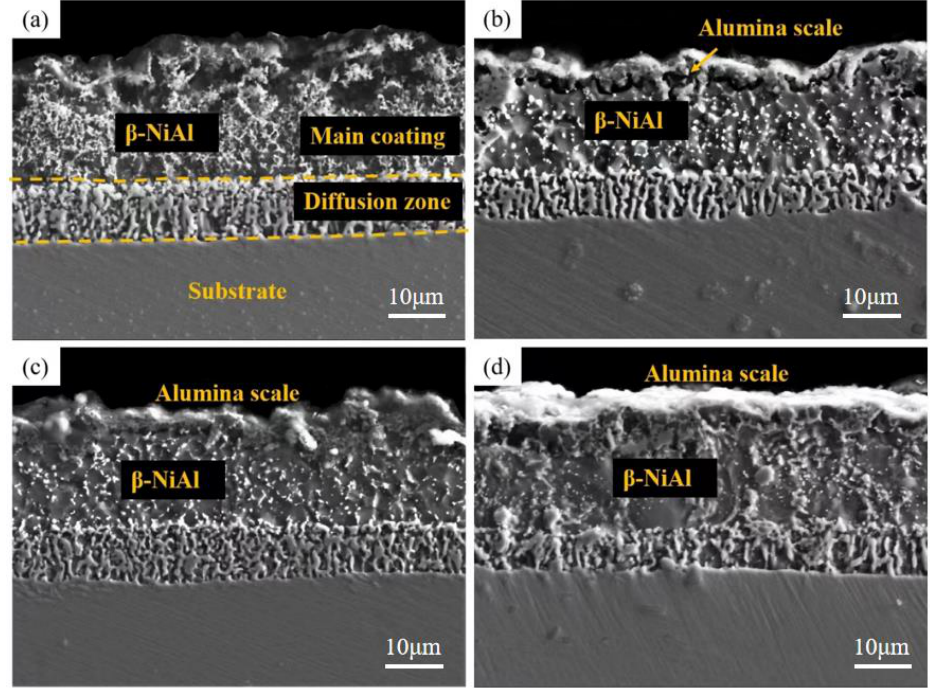
Figure 4. Cross-sectional morphologies of Al-Si coatings after pre-oxidation at different pre-oxidation temperatures for 1 h: ( a ) untreated; ( b ) 900 °C; ( c ) 950 °C; ( d ) 1000 °C.